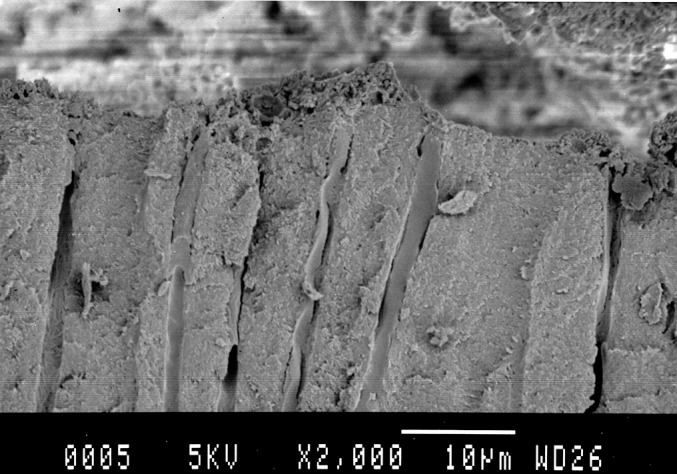
Scanning electron micrographs of the ultrasonic cleaning root canal, show that the gutta-percha into dentinal tubules.